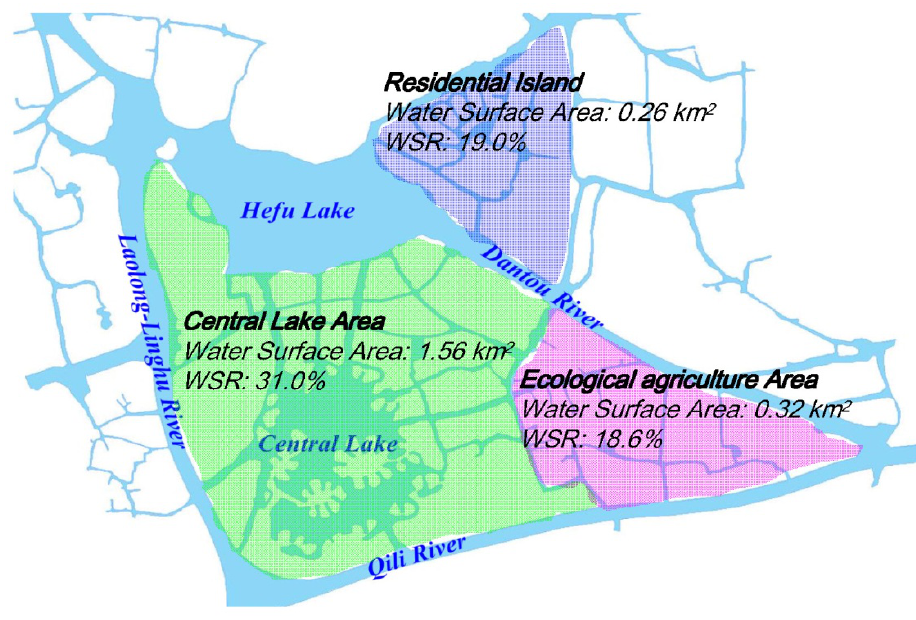
Figure 3. Water surface ratio (WSR) in the three